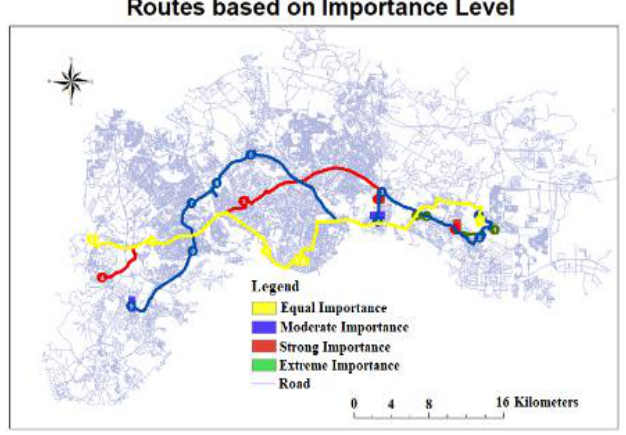
Figure 9 Routes based on MCDA Result